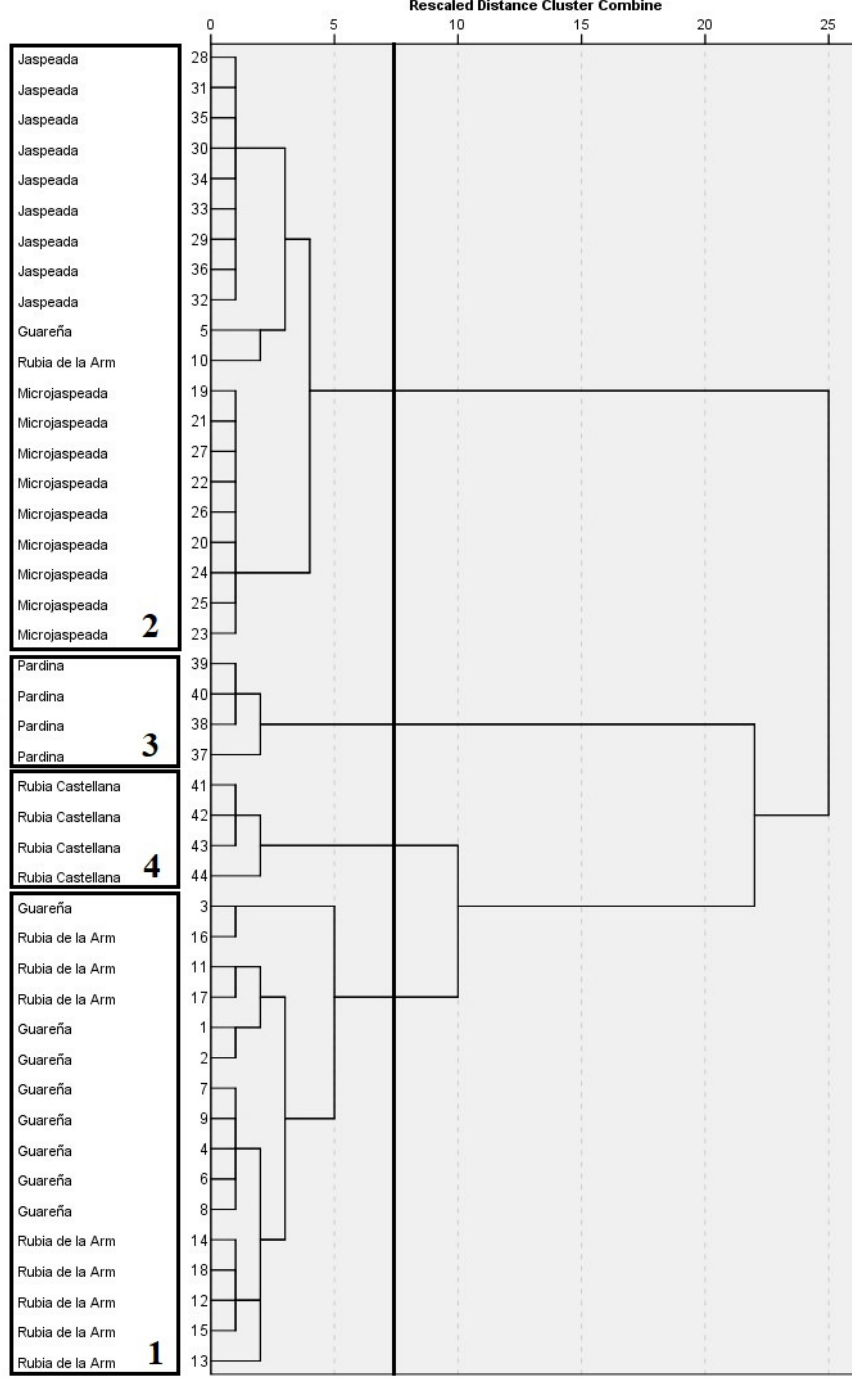
Figure 3. Dendrogram obtained from hierarchical cluster analysis with Ward’s method. On the left, the lentil samples that make up each of the clusters are grouped together. Each number (1–4) corresponds to each of the formed clusters.